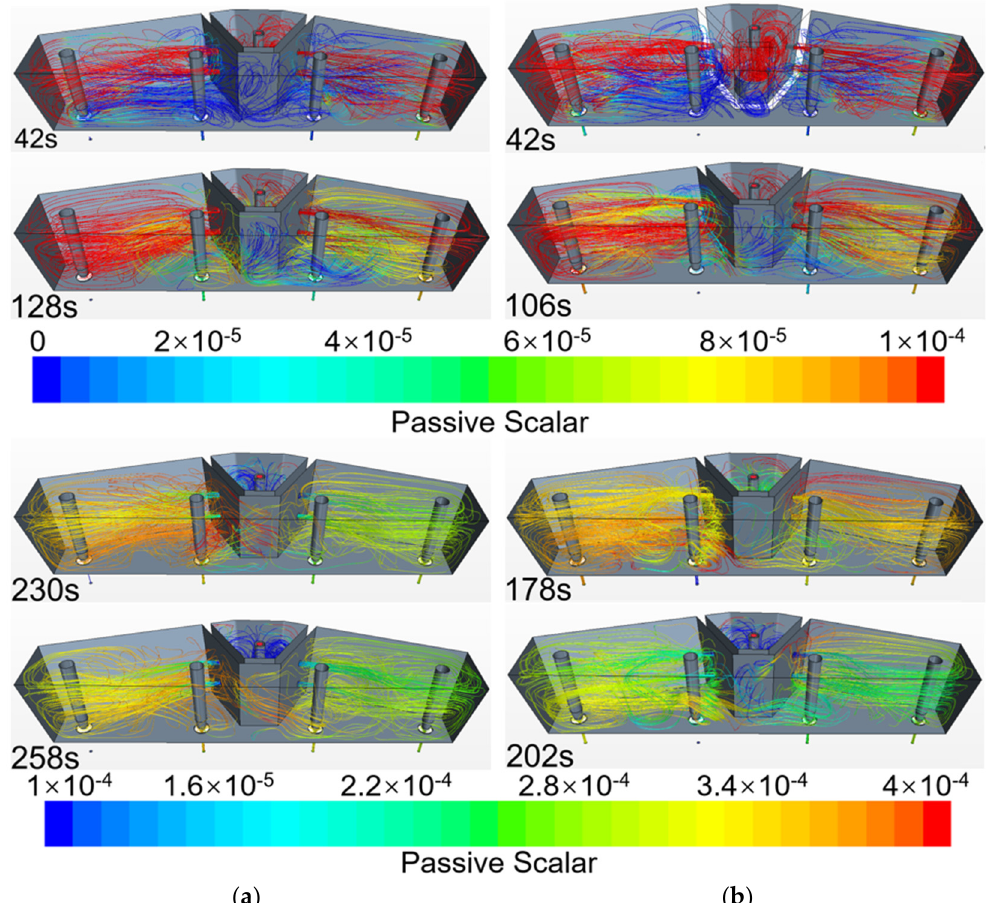
Figure 10. Streamline evolution of the u-shaped weir tundish under single-strand blockage conditions: ( a ) strand 1 blockage, ( b ) strand 2 blockage.